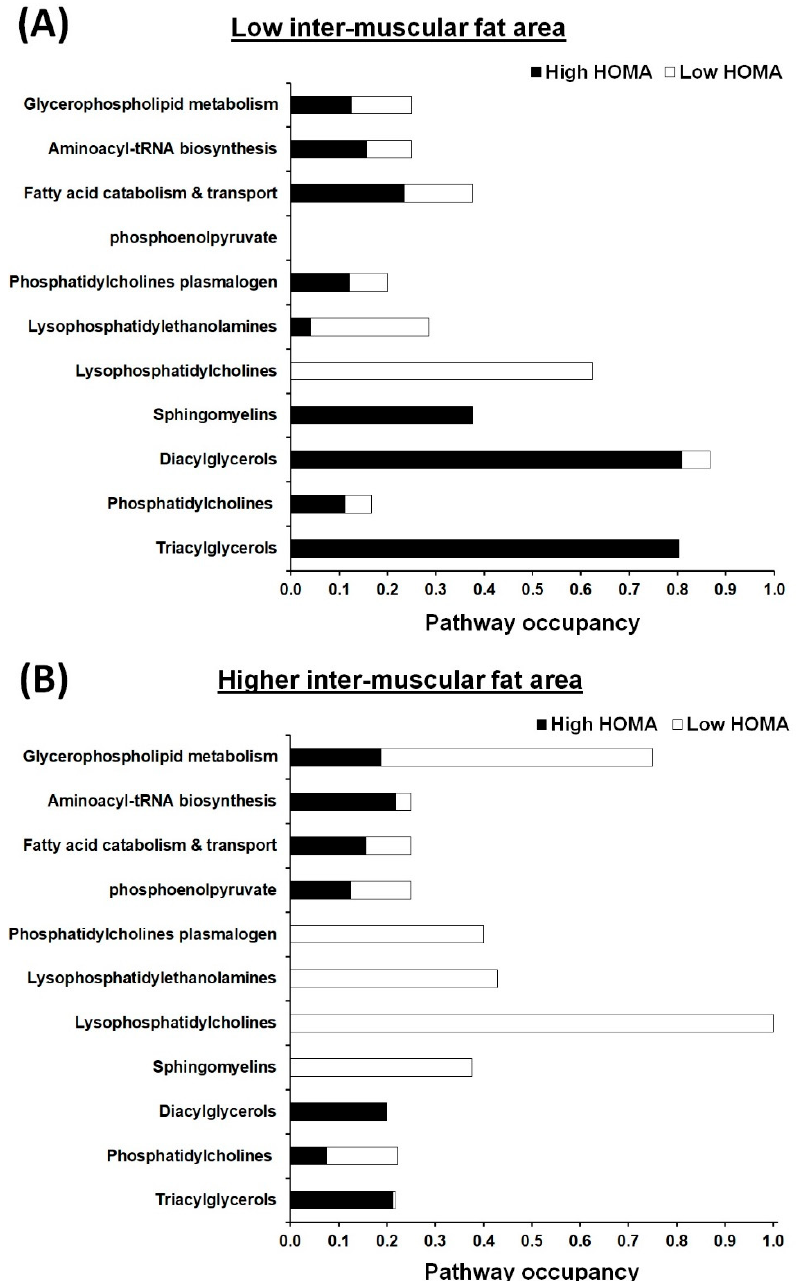
Figure 3. Pathway occupancy rates of statistically different metabolites between high and low HOMA-IR groups, in participants with the same levels of intermuscular fat (( A ) Low intermuscular fat area and ( B ) high intermuscular fat area). Black bars, the ratio of metabolites higher in High HOMA-IR than in low HOMA-IR; white bars, the ratio of metabolites higher in low HOMA-IR than in High HOMA-IR.